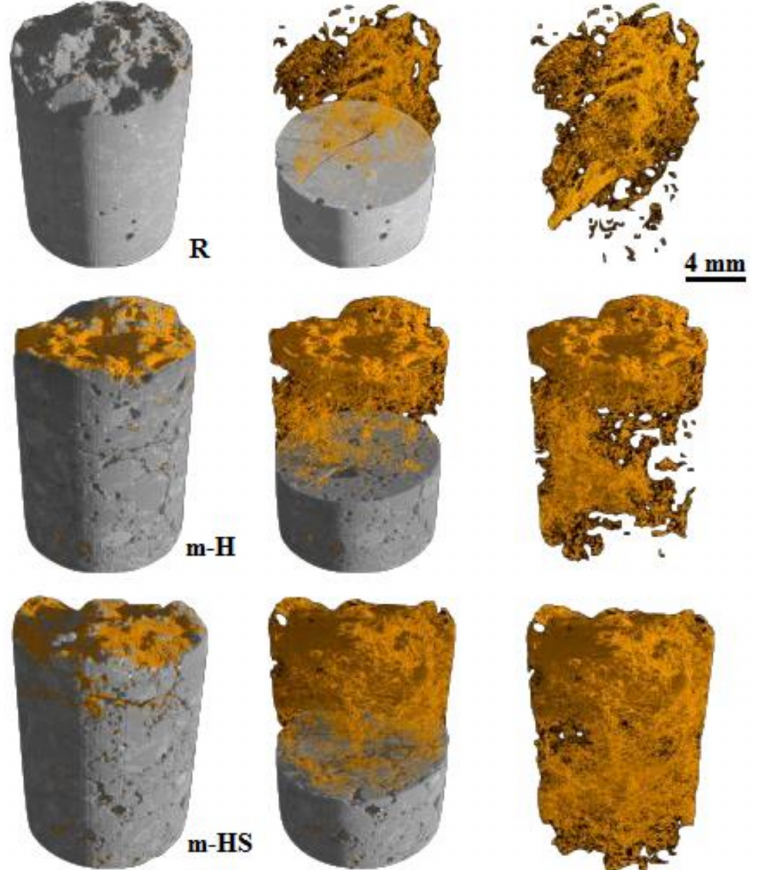
Figure 11. A 3D depiction of the healing products’ distribution in the control specimen (R) (brown color), the specimen with hydrogel bacterial spores (m-HS), and the specimen with pure hydrogel (m-H), after the process of self-healing. Left: surface of specimens in addition to the deposition; middle: dispersal of the deposits inside (Adapted with improvement from Wang